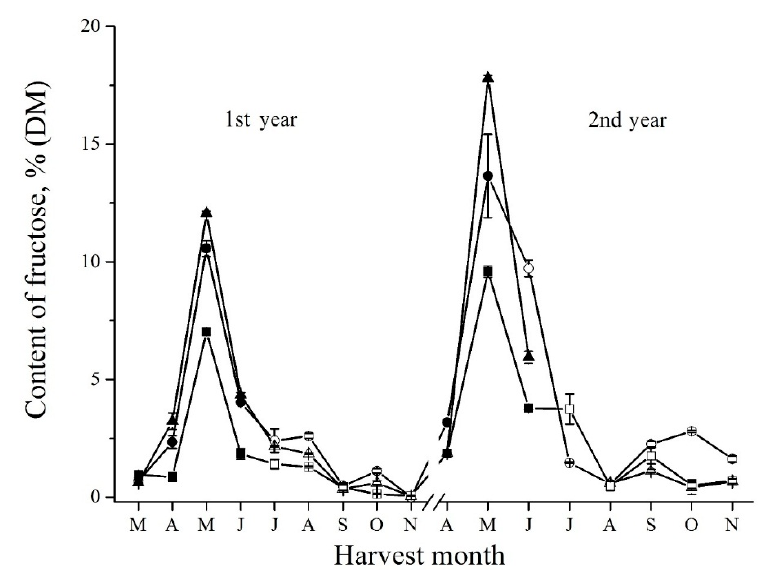
Figure 5. Seasonal fluctuations of fructose determined by enzymatic method in the tubers of Sauliai ( ● , ○ ), Albik ( ▲ , ∆ ), and Rubik ( ■ , □ ); spring tubers: ● , ▲ , ■ ; summer and autumn tubers: ○ , ∆ , □ .